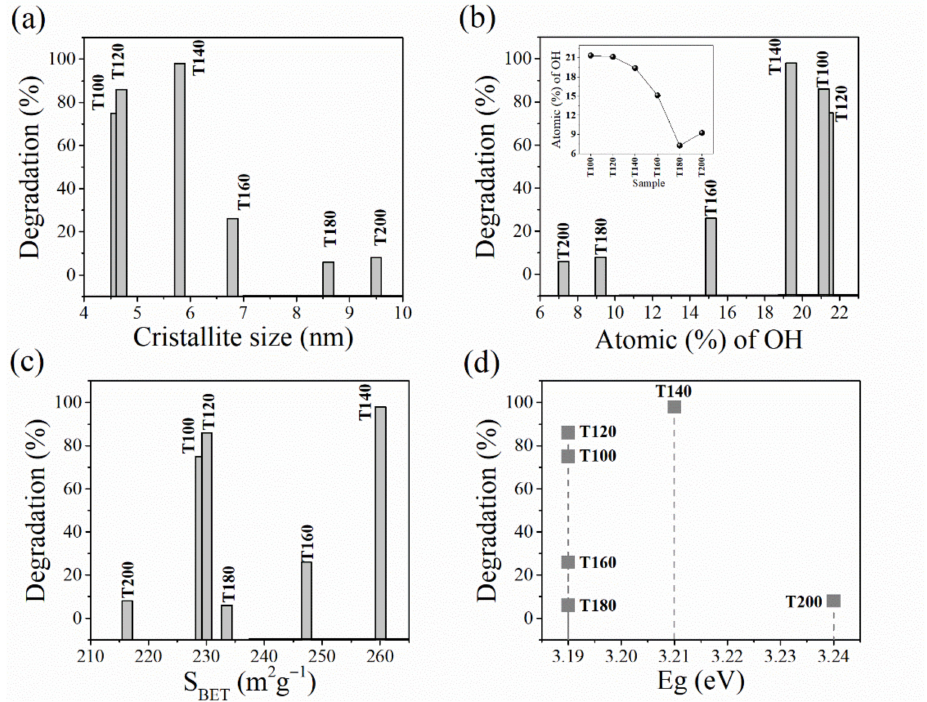
Figure 9. Analysis of degradation (%) in terms of the structural properties: ( a ) crystallite size, ( b ) atomic (%) of OH groups; inset variation of atomic (%) OH for each sample, ( c ) surface area-BET, and ( d ) Eg